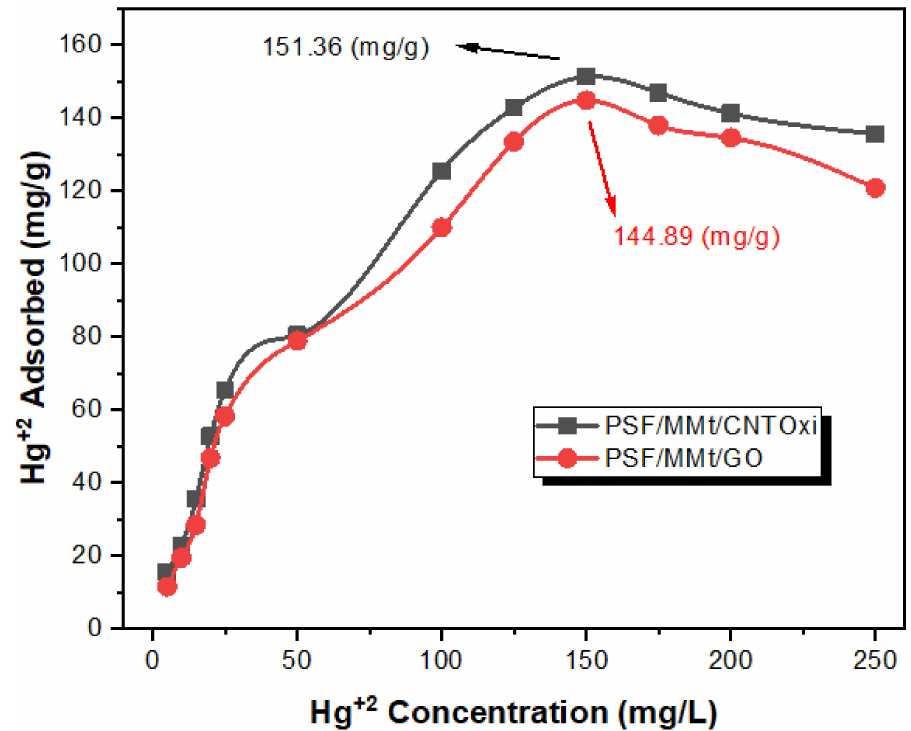
Figure 6. The adsorption profile of Hg +2 ion on 25 mg of PSF/MMt/GO and PSF/MMt/CNTOxi, respectively, in relation to the concentration at pH 2.0 and 25 ◦